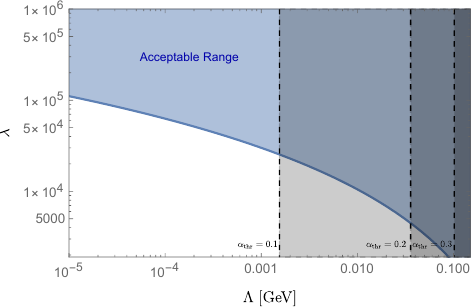
Figure 6 . Region of the parameter space { λ, Λ } that allows to reproduce the correct axion DM relic density. The blue shaded region ensures that the QCD axion does not roll until T the dark sector is spontaneously broken. Finally the gray shaded regions signal the parameter space for which our expressions for the thermal friction breakdown before T options of the threshold value of the running